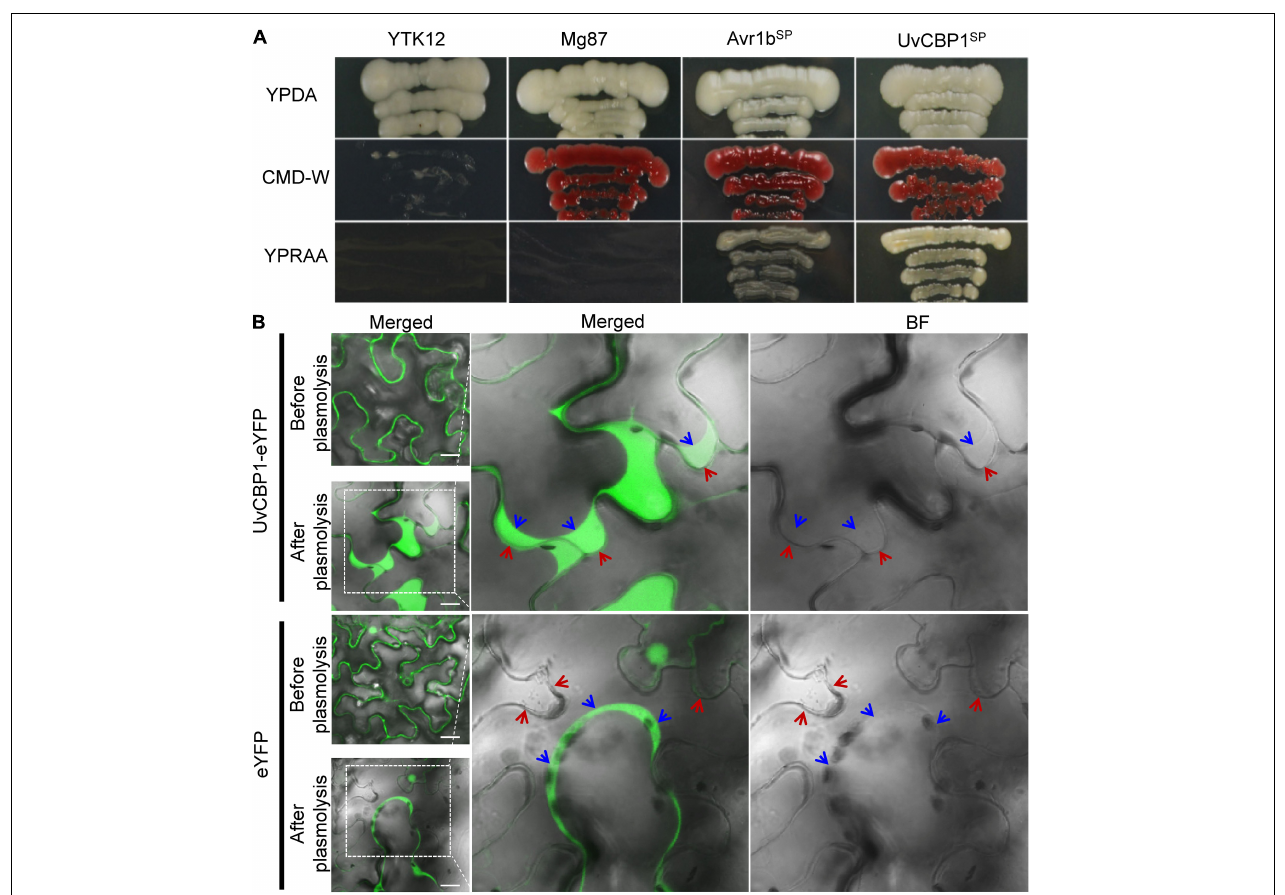
FIGURE 2 | UvCBP1 encodes a secreted protein. (A) Validation of UvCBP1 signal peptide (SP). The DNA fragment encoding SP of UvCBP1 was cloned into pSUC2, in frame with an invertase gene. The resultant plasmid was transformed into YTK12 that is unable to utilize raffinose. SP of UvCBP1 could enable YTK12 to grow on YPRAA medium, indicating its functionality. SP of Avr1b and N-terminus of Mg87 were applied as positive and negative controls, respectively. (B) UvCBP1-eYFP is located in the apoplast of leaf cells in Nicotiana benthamiana. UvCBP1-eYFP or eYFP was transiently expressed in N. benthamiana and examined by confocal microscopy. After plasmolysis with 10% sucrose, fluorescence signal of UvCBP1-eYFP was clearly detected in the extracellular space, while eYFP was in the cytoplasm and nucleus. The blue arrows indicate plasma membrane and the red arrows indicate plant cell wall. Scale bar, 20 µ m.